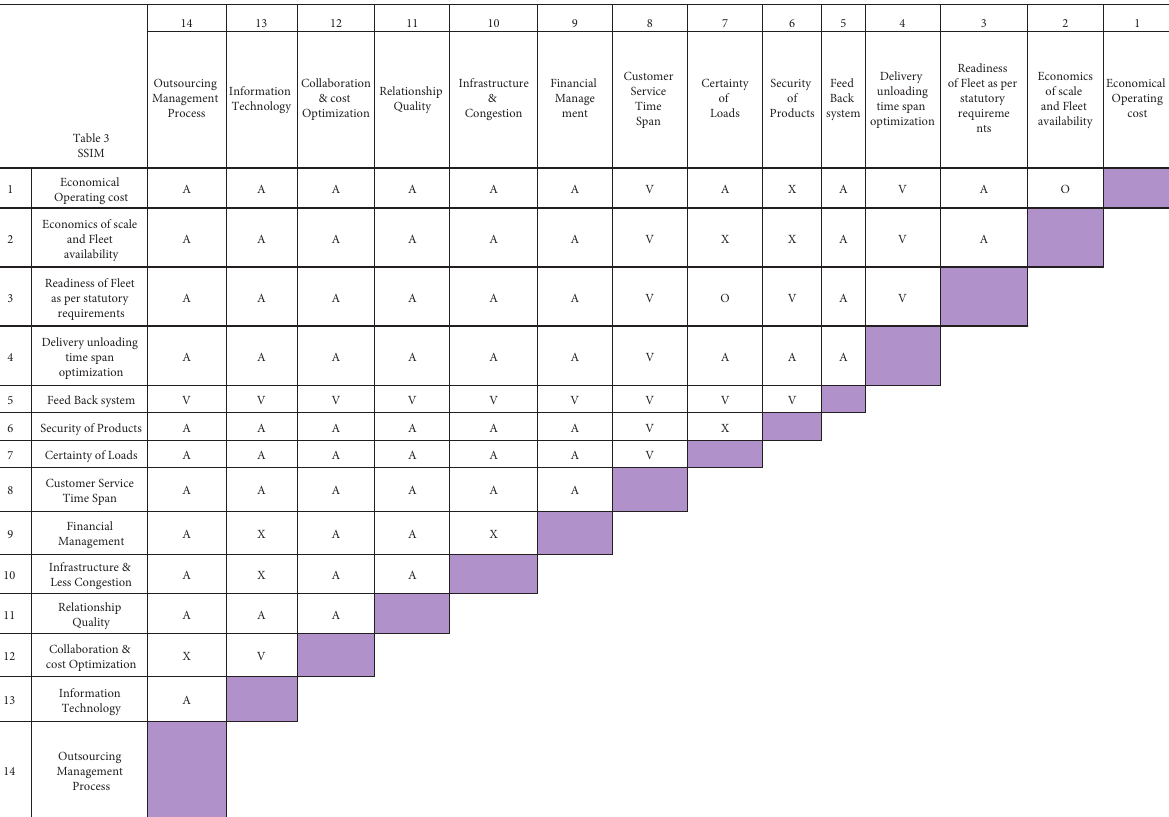
Table 3: SSIM for